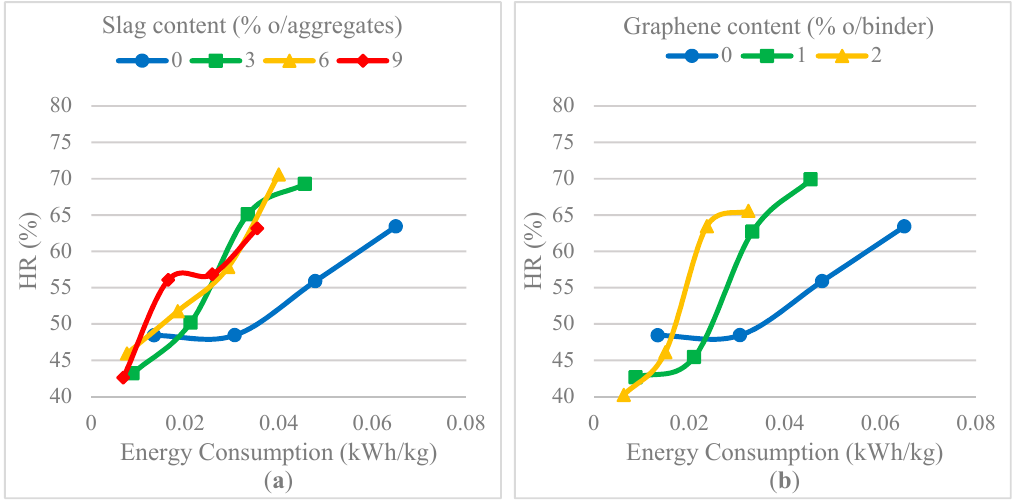
Figure 14. Effect of slag ( a ) and graphene ( b ) on the Healing Efficiency Figure 14. E ff ect of slag ( a ) and graphene ( b ) on the Healing E ffi